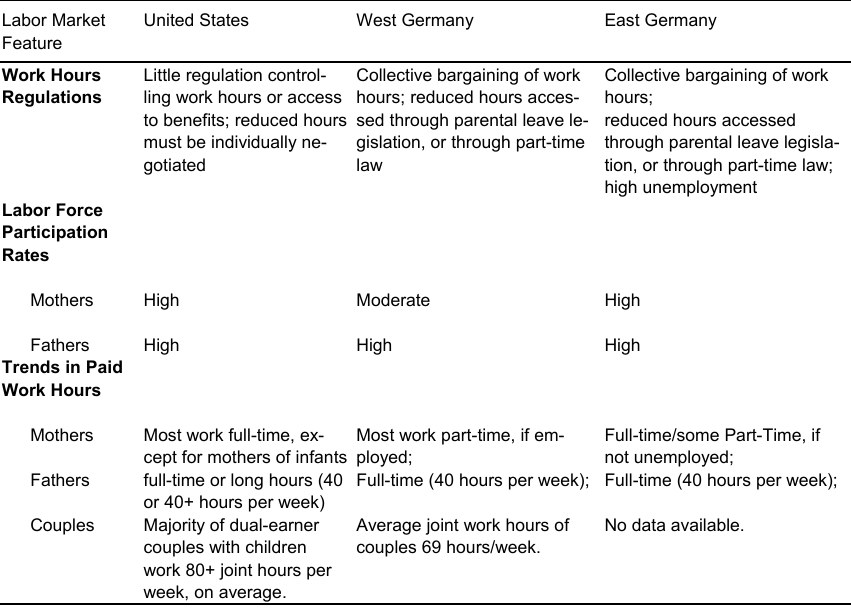
Table 2 Comparing Labor Market Contexts in the United States, West, and East Germany Using a Range of Indicators Labor Market